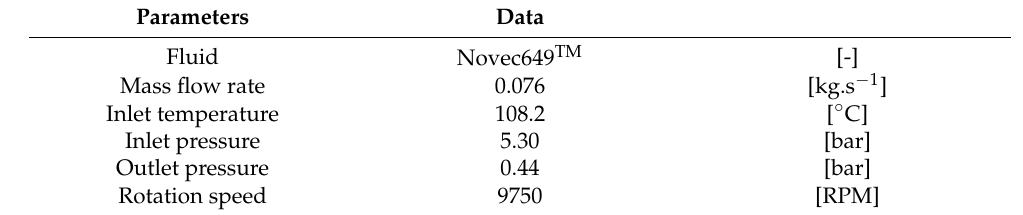
Table 5. Design point.